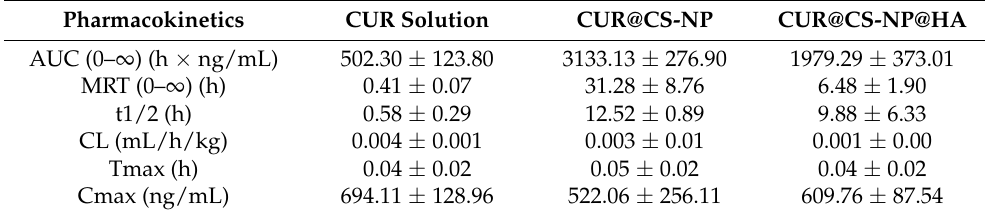
Table 5. Pharmacokinetic parameters of CUR@CS-NPs (1.5 mg/kg) by tail vein injection in rats.